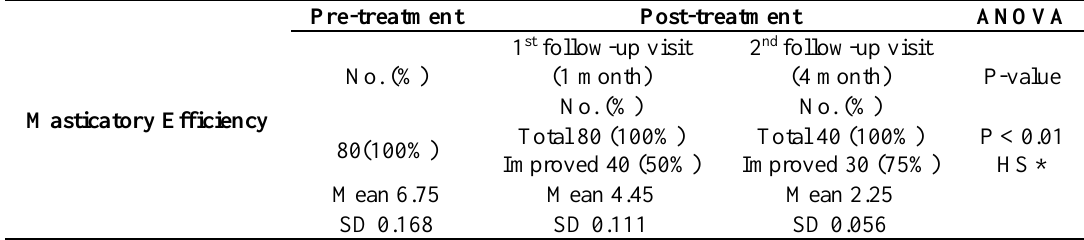
Table 1 : Masticatory efficiency (before and after